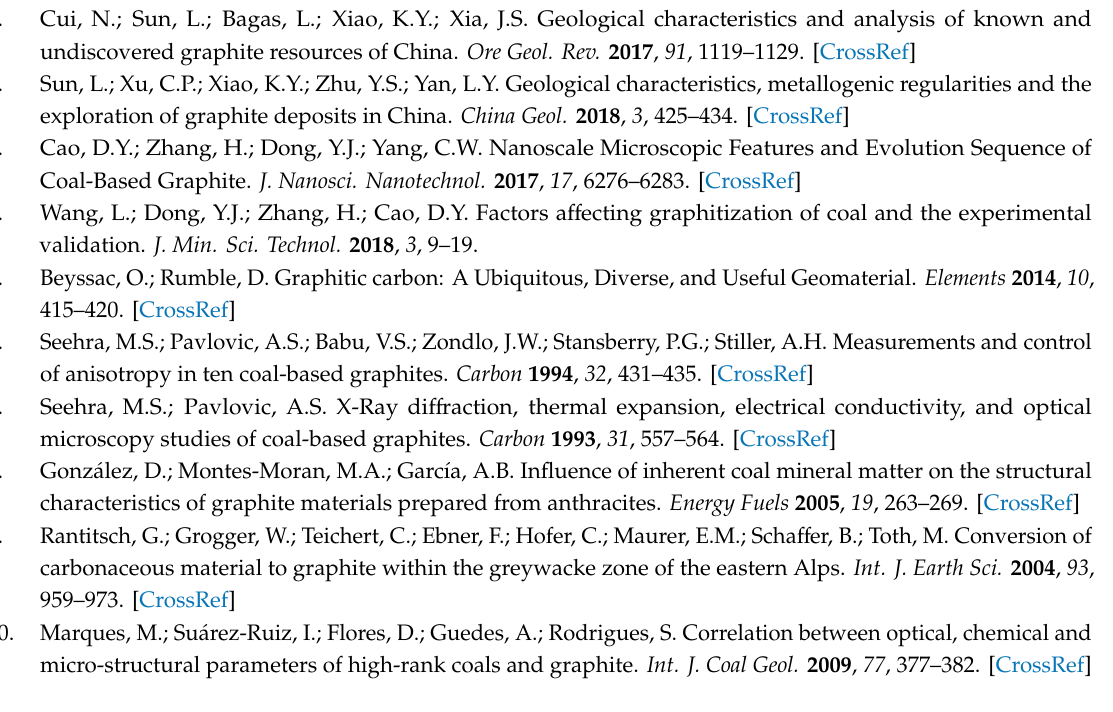
Table S1: Raman spectra parameters of di ff erent deformed samples away from the intrusion. Author Contributions: Software, Y.P. and Z.D.; writing—original draft, L.W. and D.C.; supervision, D.C.; formal analysis, L.W.; data curation,